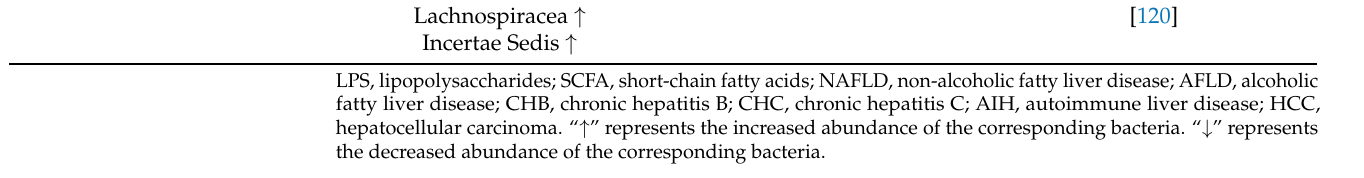
Table 2. Probiotics and prebiotics for the treatment of chronic liver